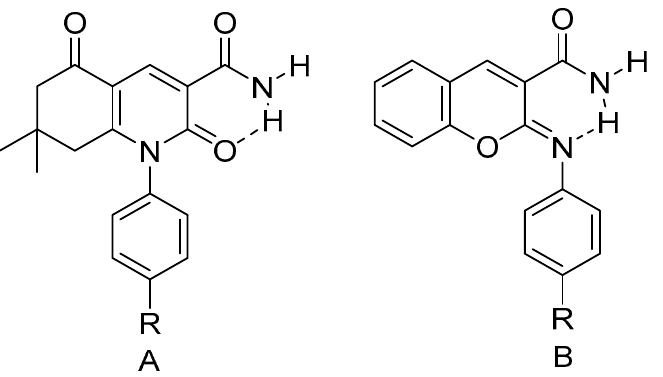
Figure 26. Primary amides used to estimate hydrogen bond strength. Taken from